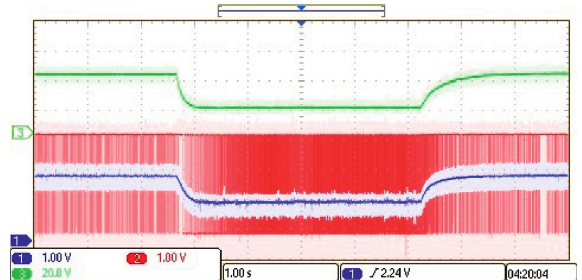
Figure 19: Output voltage (green), SSTA controller signal (blue), and ΣΔ M output (red).